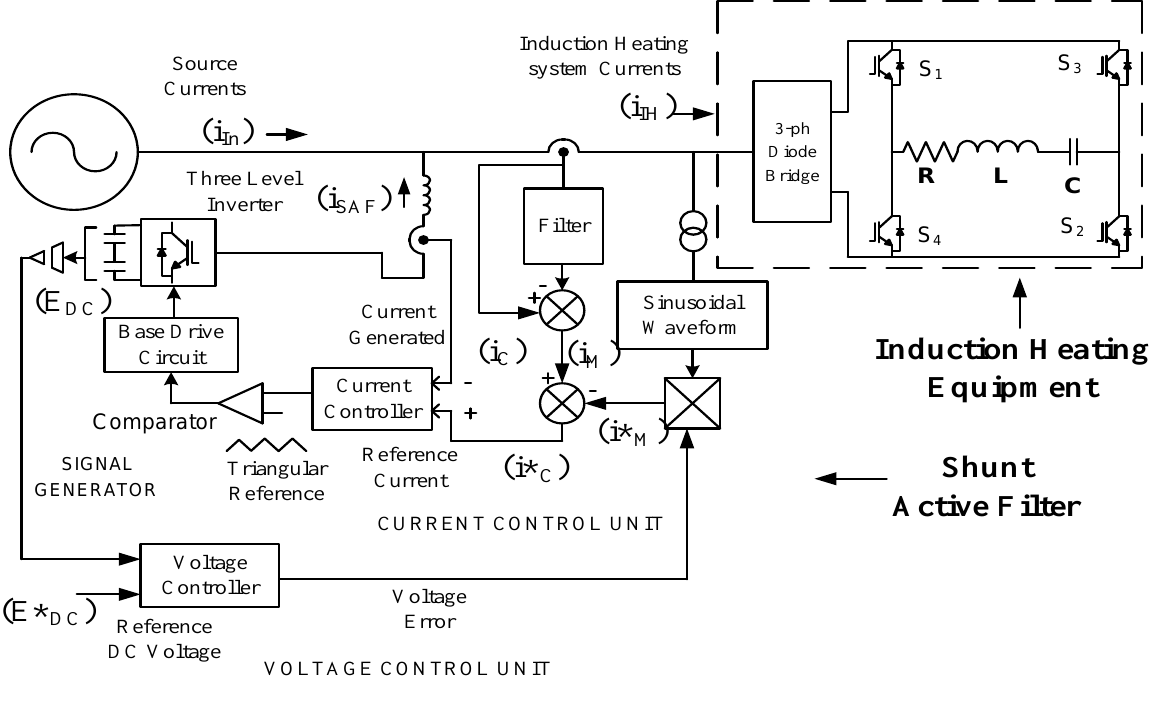
Figure 2. Basic circuit diagram of IHE using Shunt Active